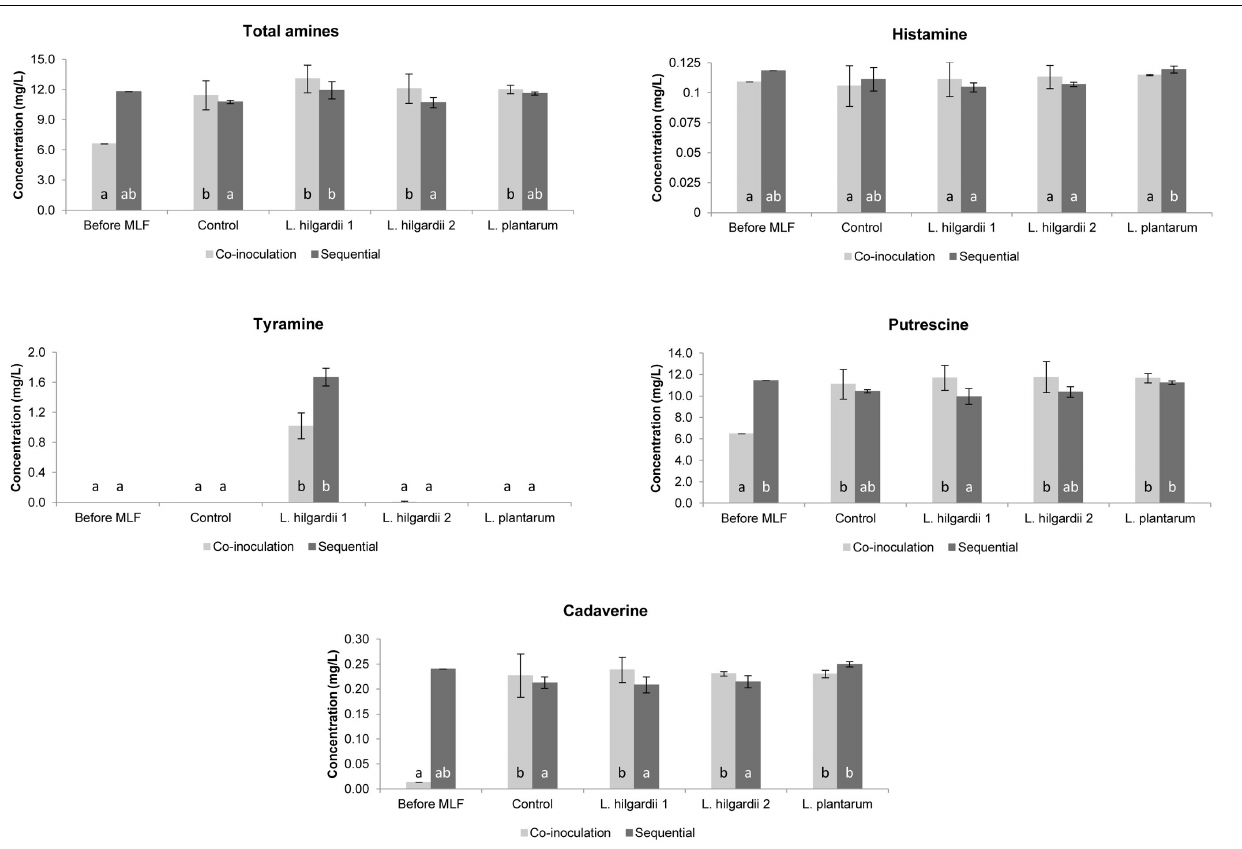
FIGURE 5 |The individual and total biogenic amine content of all treatments in the Pinotage wine fermentations before and after MLF. Each bar indicates the mean and the SEM. Different letters indicate significant differences ( p < 0.05) between treatments of the same MLF inoculation